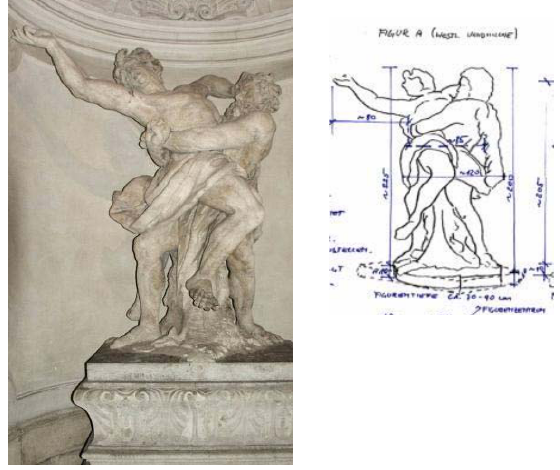
3D-MODELLING 9. Step (Modelling of surfaces) So far there are 3d-lines but no surfaces as base for reconstruction. Using the existing 3d-lines, profile sections and the undistorted pictures a surface model is going to be